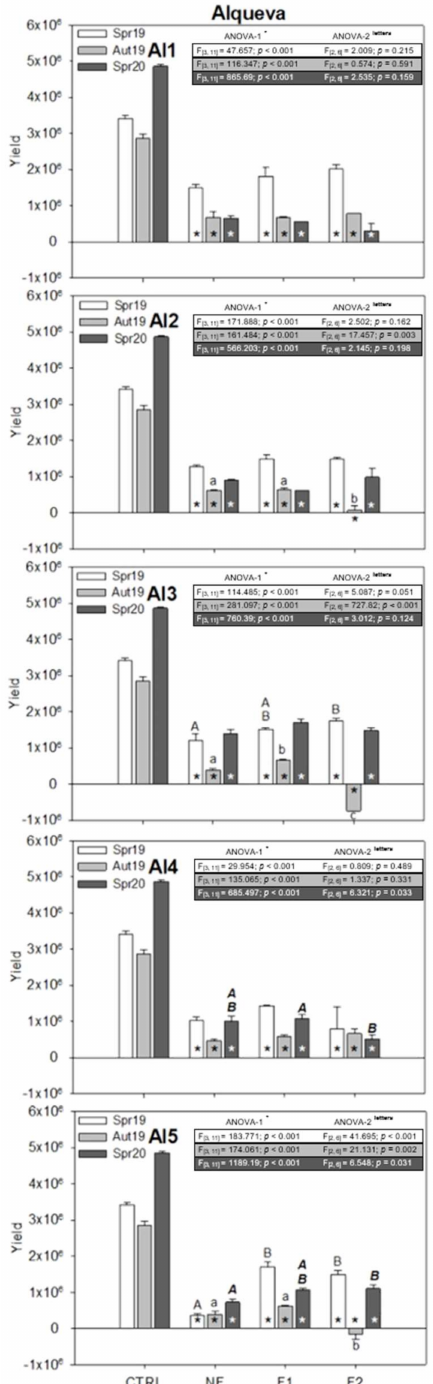
Figure 5. Results of Yield of R. subcapitata from the Alqueva reservoir, when exposed to treatments: control (CTRL) and natural water treatments (NF—Non-filtered water; F1 and F2—filtered with 1.2 µ m and 0.22 µ m, respectively). Data are stated as mean ± standard error (SE); n = 3. * Stands for significant differences detected by Dunnett test. Different letters (A, B for Spr19; a, b for Aut19 and A , B for Spr20) stands for significant differences between treatments, detected by Tukey